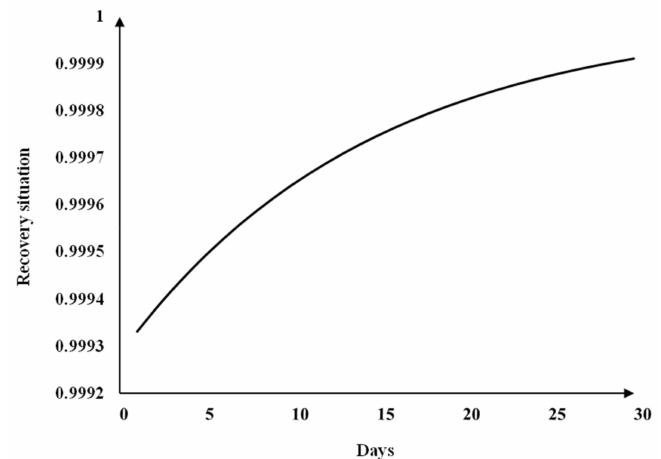
Figure 1. Thirty day metal products, machinery and equipment repair service sector recovery